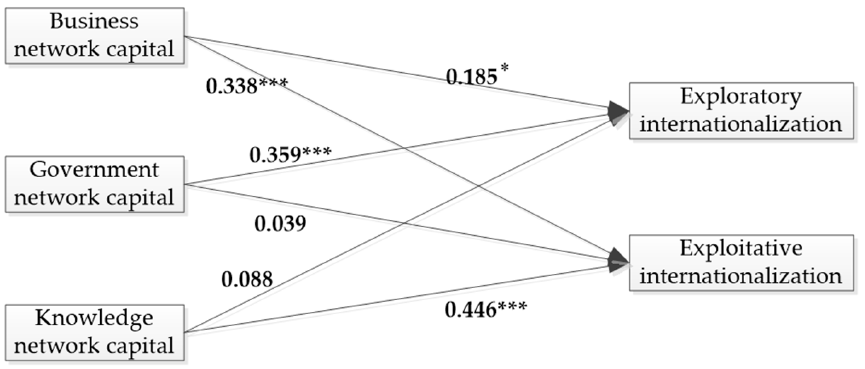
Figure 2. Path coefficients of theoretical model. Note: * p < 0.1, *** p < 0.001, parameters are standardized parameter estimates.